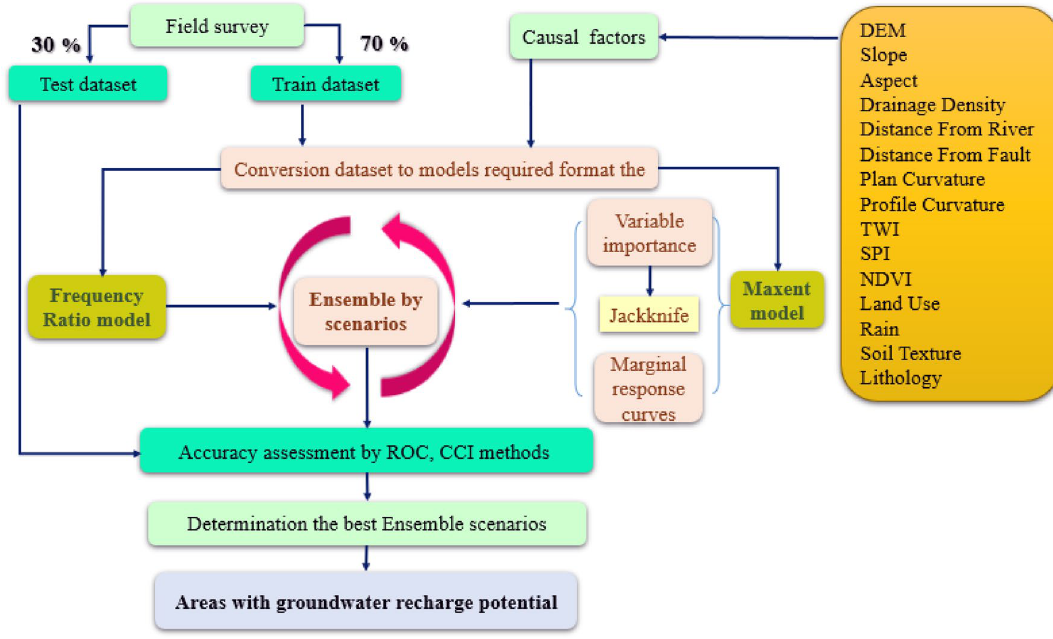
Figure 2. Flowchart of carrying out the methodology in this